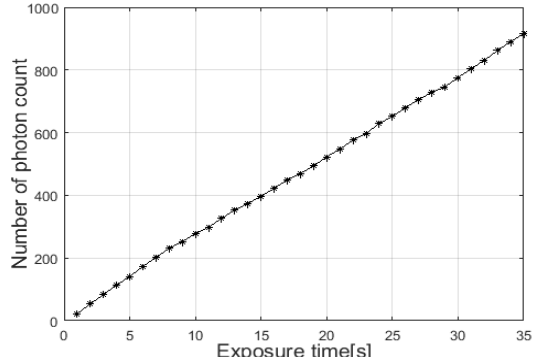
Figure 2. An example of the pixel responses to the exposure time. Only the pixels that have R 2 value bigger than 0.999 at the linear fitting were used for the energy calibration.